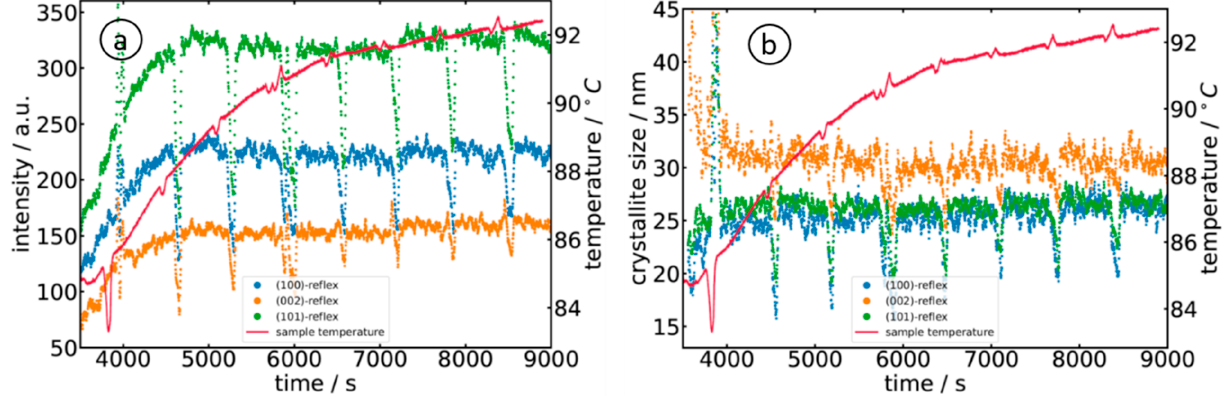
Figure 8. Evaluation of the diffractograms collected during the reaction of Zn(acac) 2 in 10 − 3 M NaOH (sample A) as a function of time and temperature: ( a ) temporal evolution of the diffraction peak intensities and ( b ) evolution of the crystallite size as calculated by the Scherrer equation. The periodic drops in intensity and crystallite size are due to the periodic interruption of the stirring process, so the particles in the solution tend to move out of the volume probed by the X-ray beam.